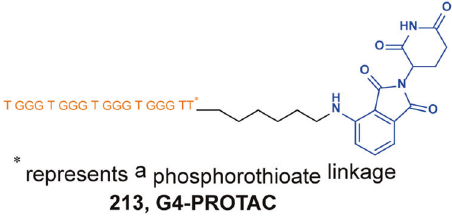
Fig. 66 The representative PROTAC targeting RHAU